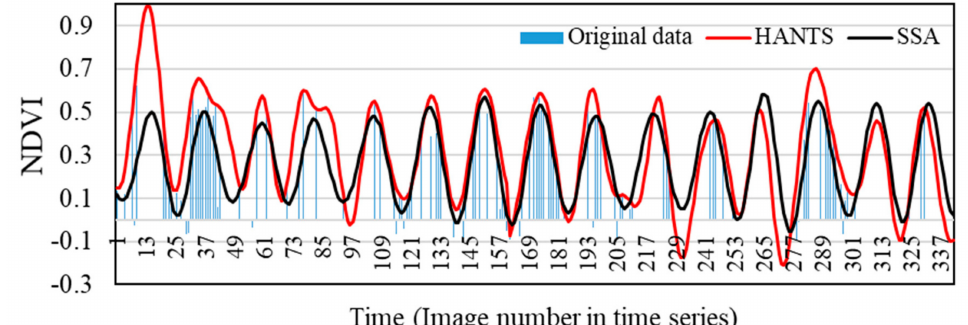
Figure 13. Original and reconstructed data signal using HANTS and M-SSA algorithms on NDVI time series for one